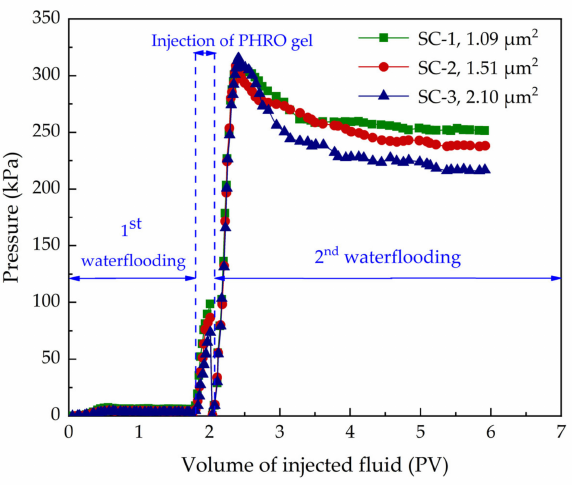
Figure 13. Pressure response of PHRO during conformance control experiment (the formula of gel is